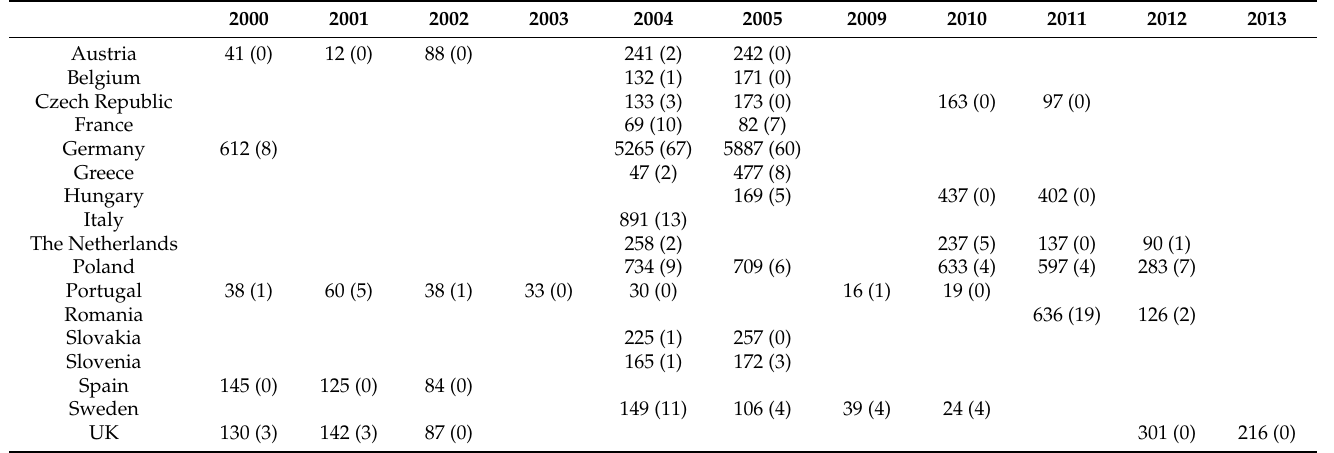
Table A2. Sample and number of detections per country and year for food